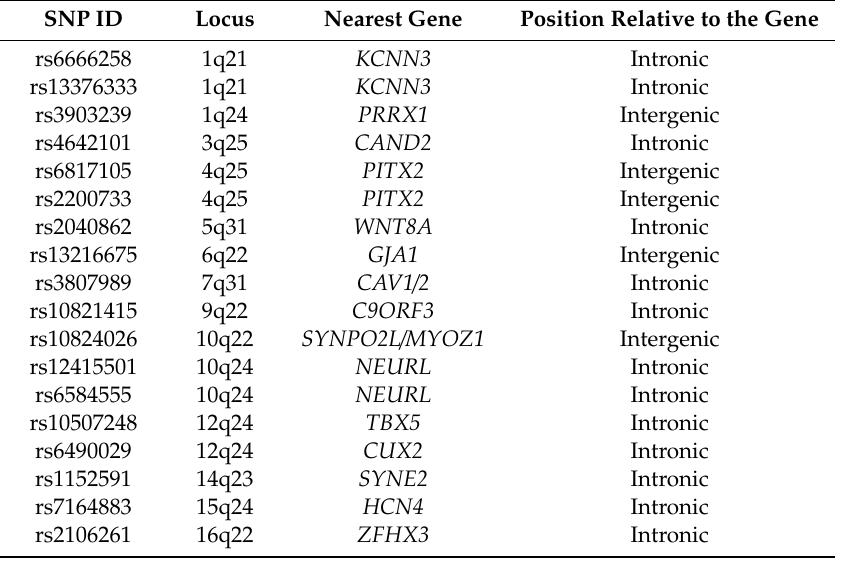
Table 2. Main genetic loci identified by GWAS in association with AF.